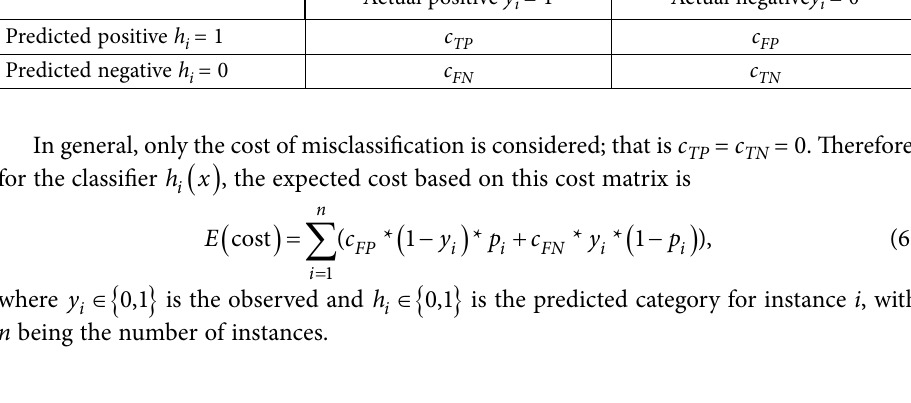
Actual positive y i =